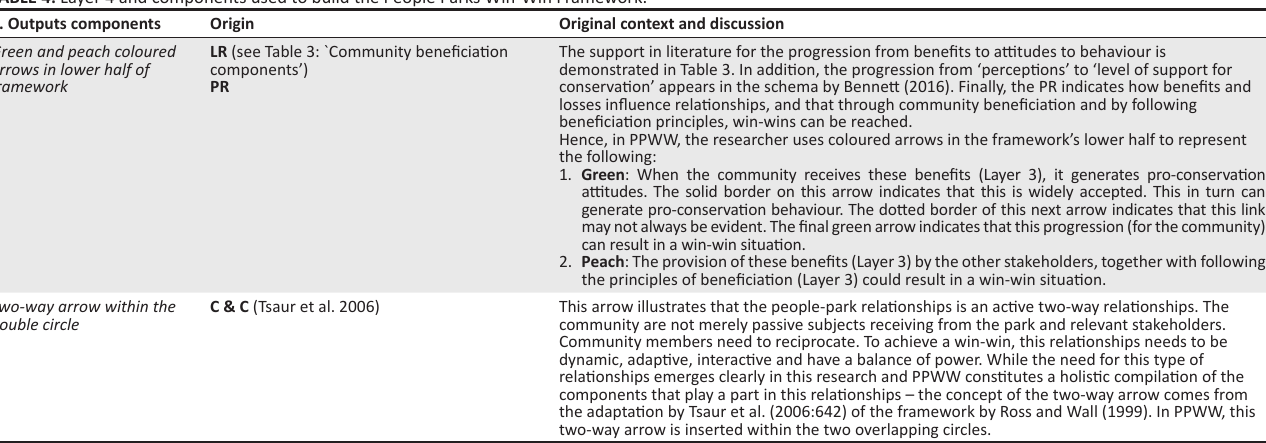
TABLE 4: Layer 4 and components used to build the People Parks Win-Win Framework.